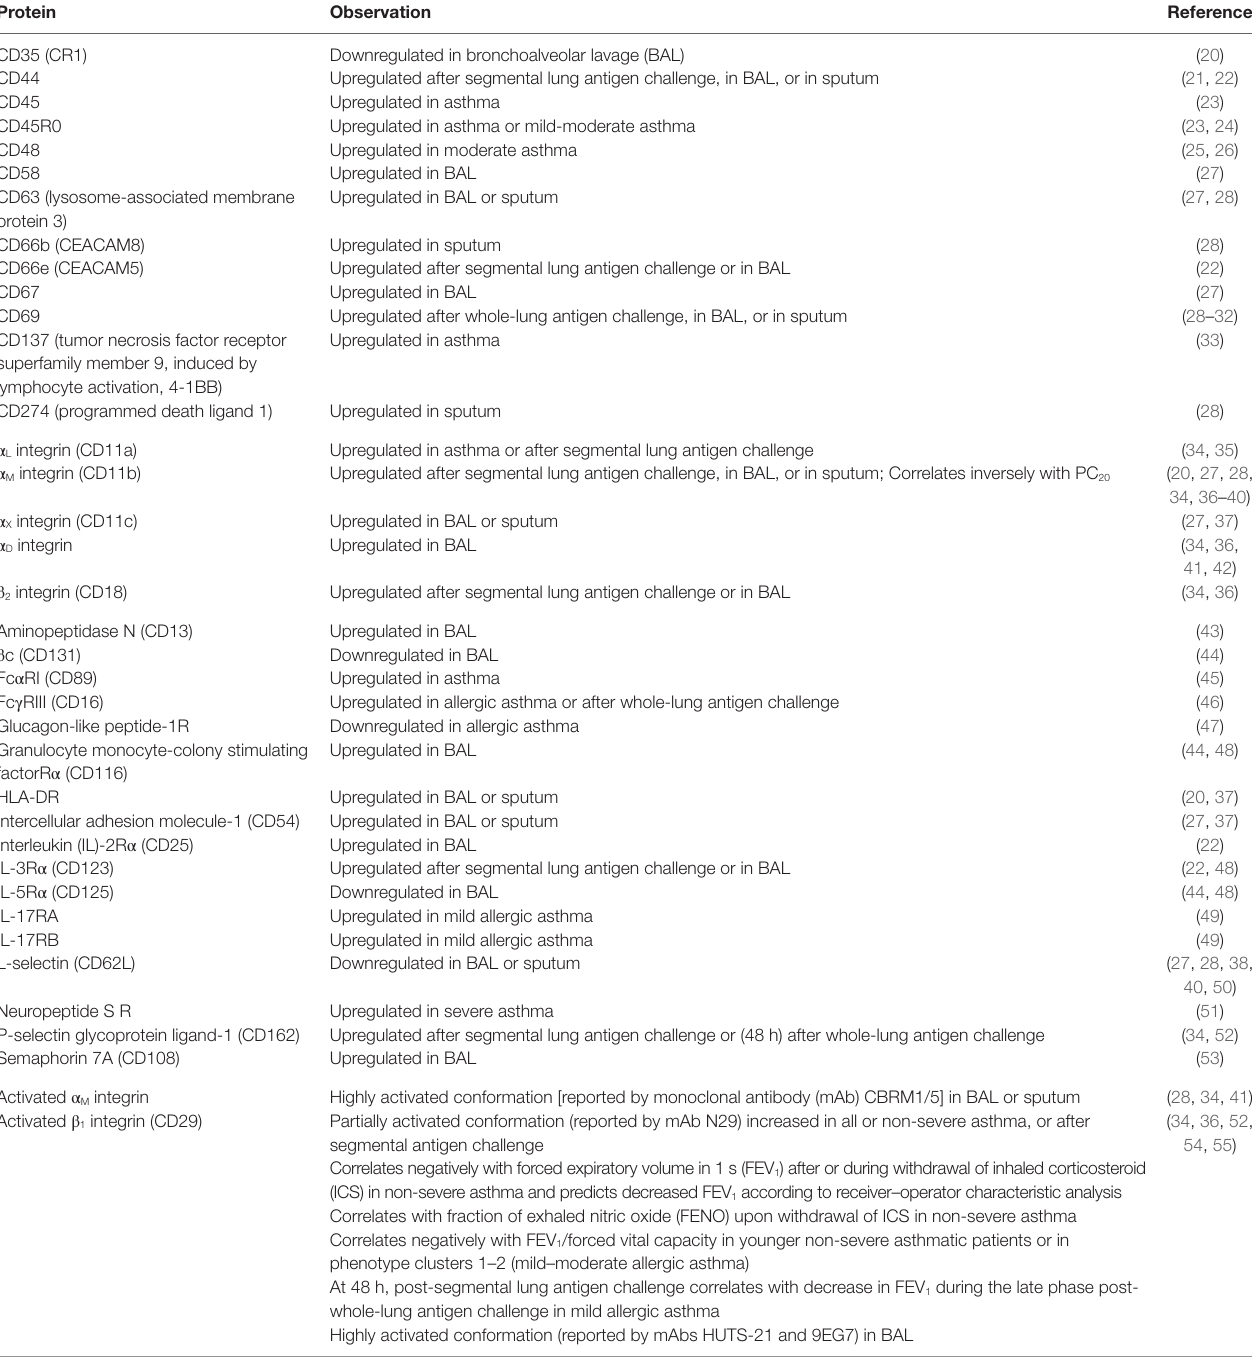
TAbLe 1 | Eosinophil surface proteins altered after antigen challenge or in the airway, or associated with asthma or aspects of asthma.